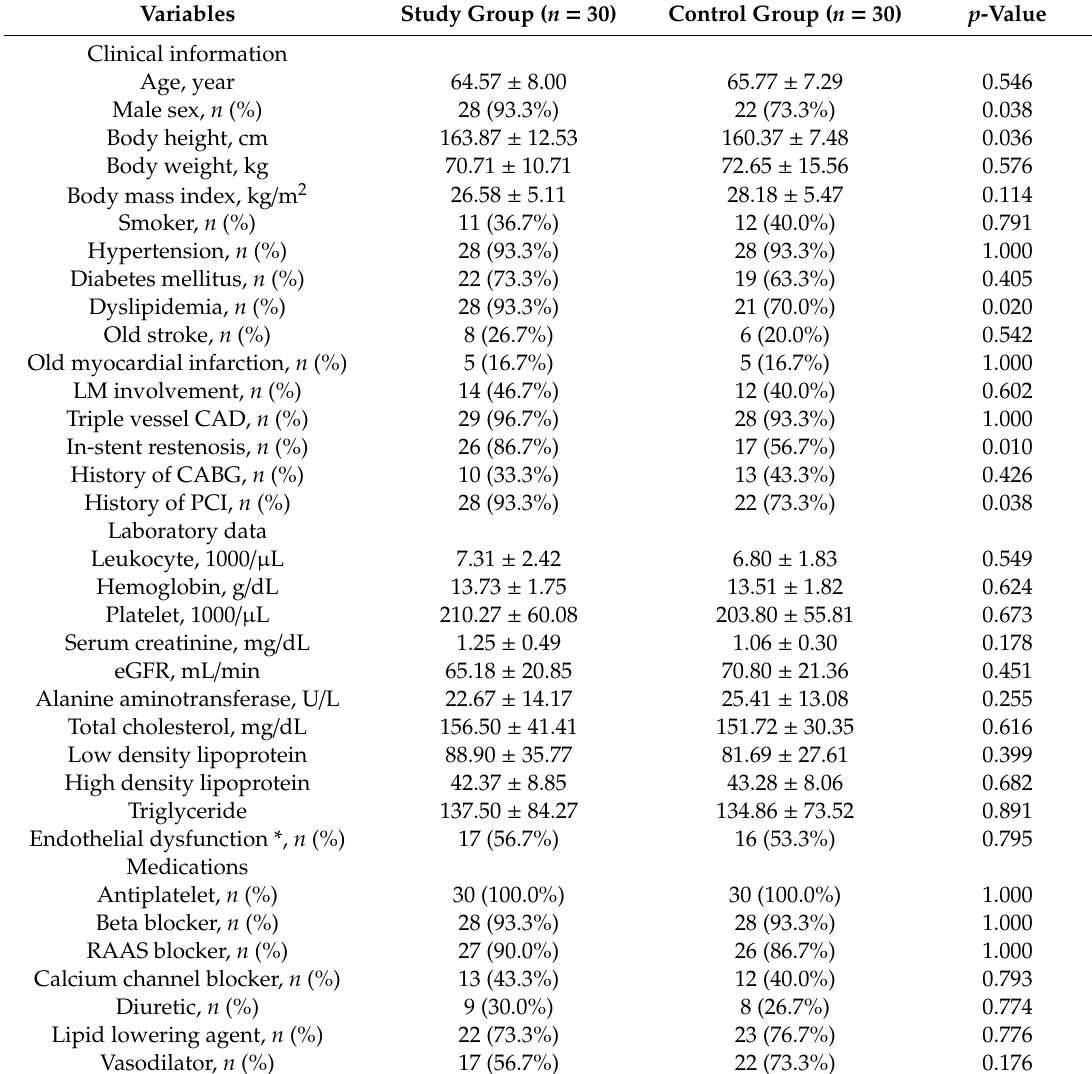
Table 1. Baseline